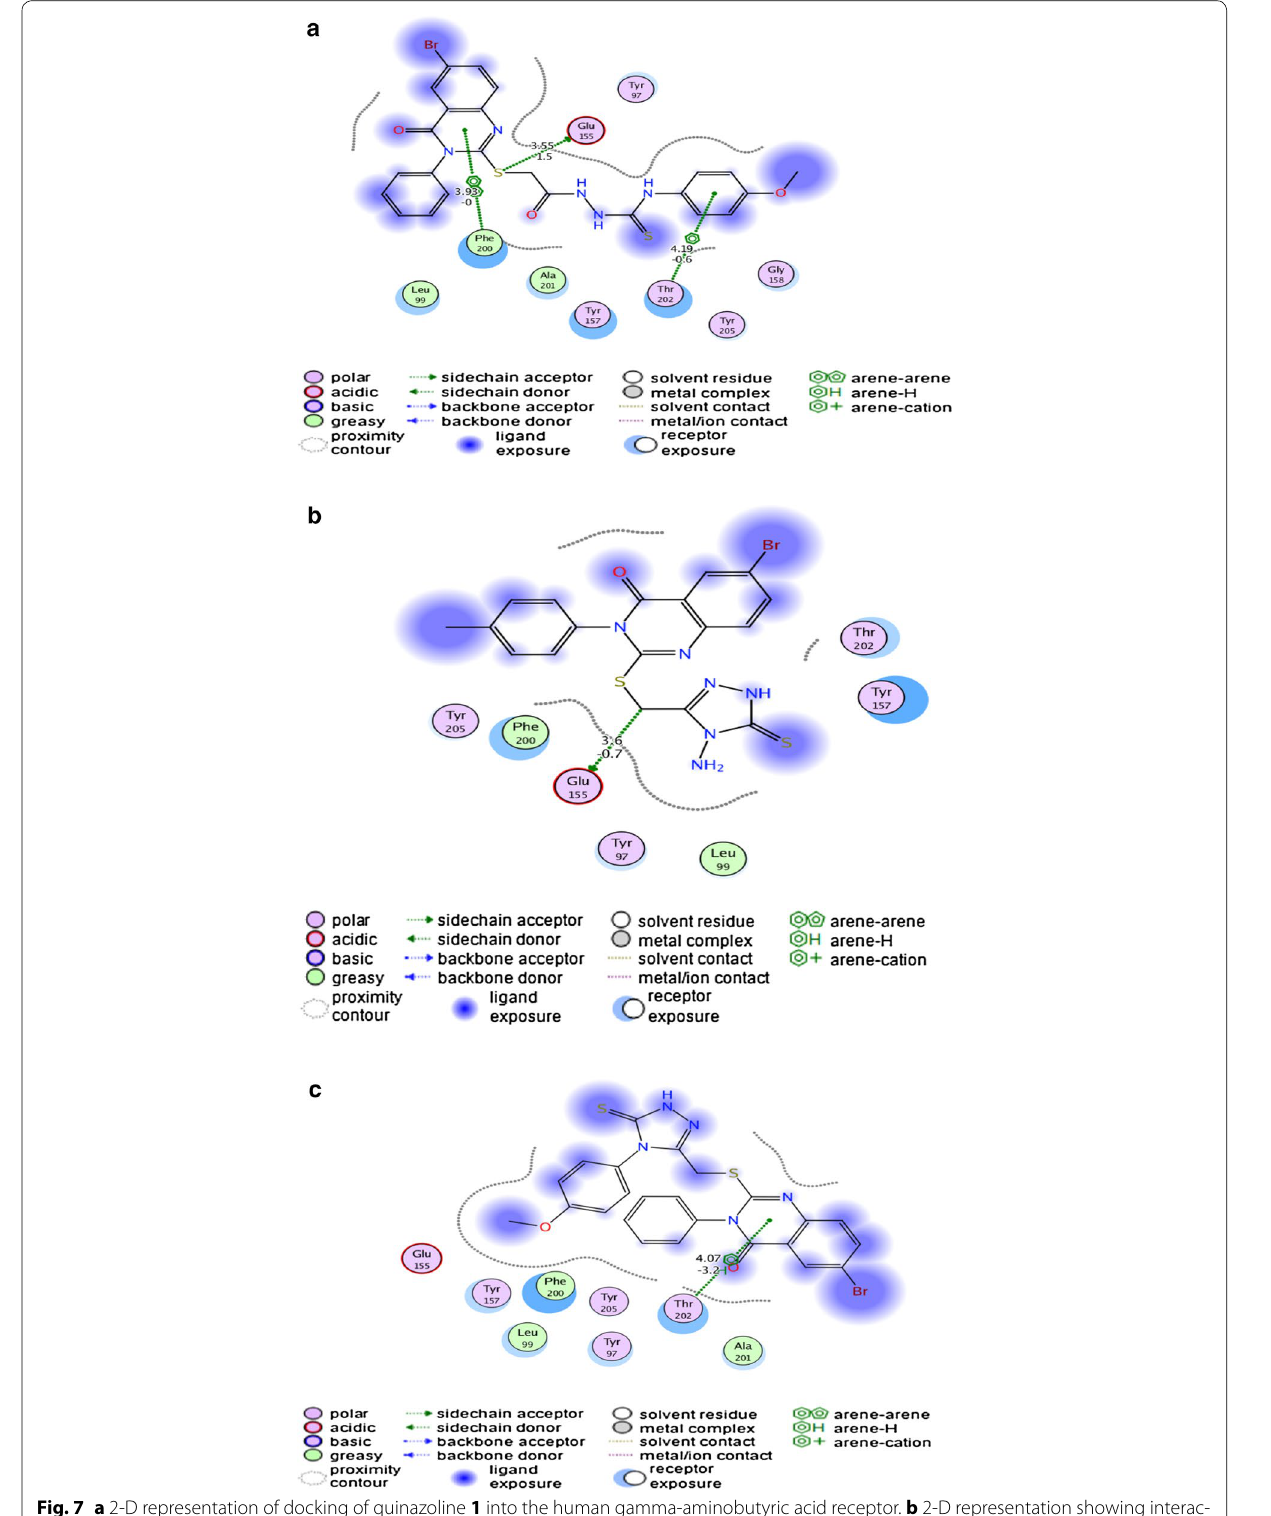
Fig. 7 a 2‑D representation of docking of quinazoline 1 into the human gamma‑aminobutyric acid receptor. b 2‑D representation showing interac‑ tions between human gamma‑aminobutyric acid receptor and the quinazoline 2 . c 2‑D representation showing interactions between human gamma‑aminobutyric acid receptor and the compound